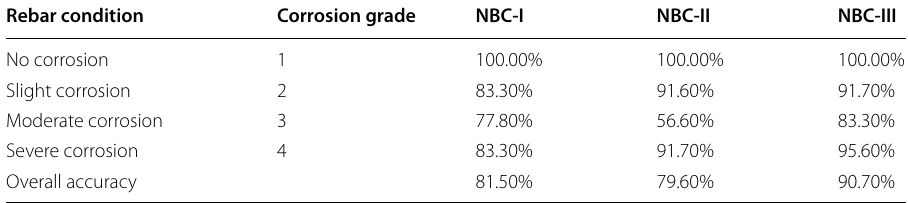
Table 4 Model accuracy